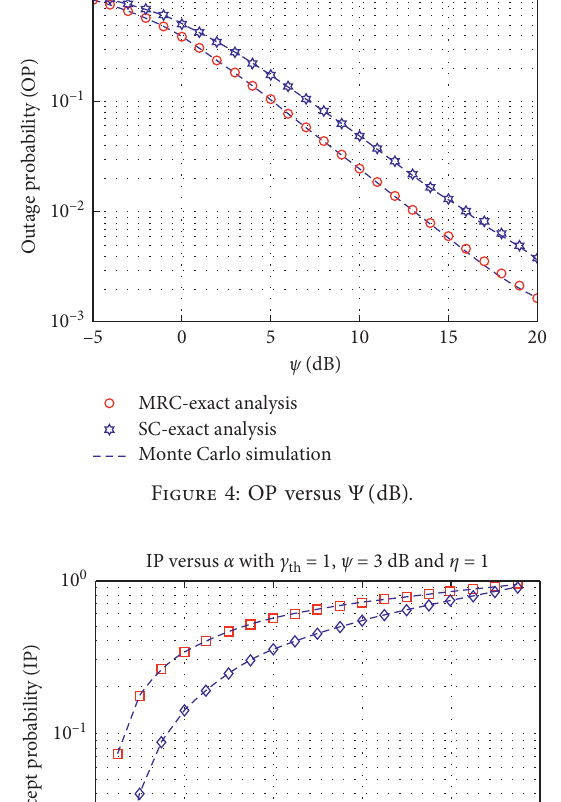
Figure 3: IP versus Ψ ( dB ) .